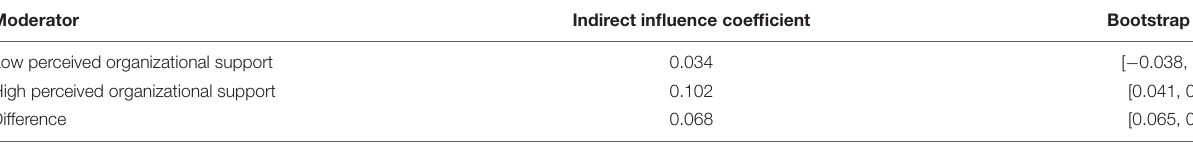
TABLE 5 | Bootstrap test results of moderated